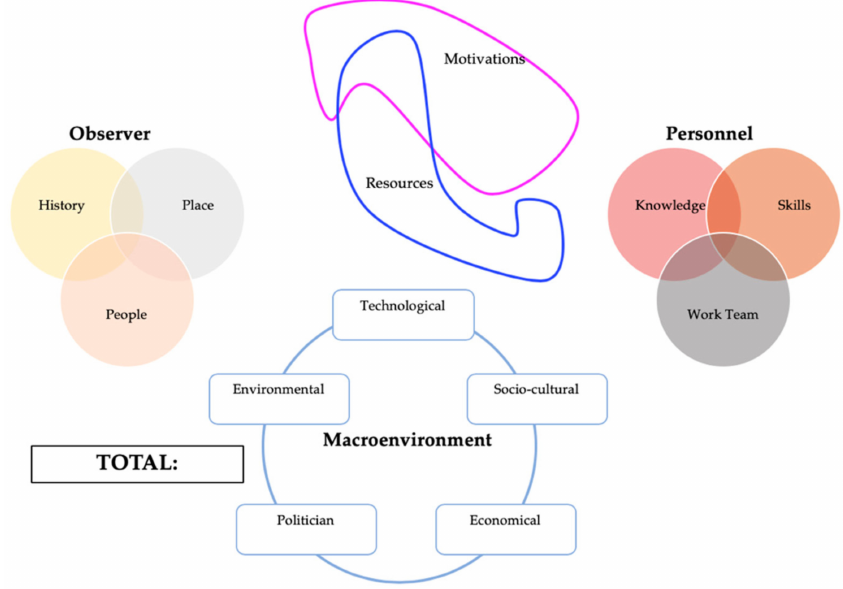
Figure 2. Business Observation Tool (BOT) Analysis. Source: own elaboration based on slideshare.net Á lvaro